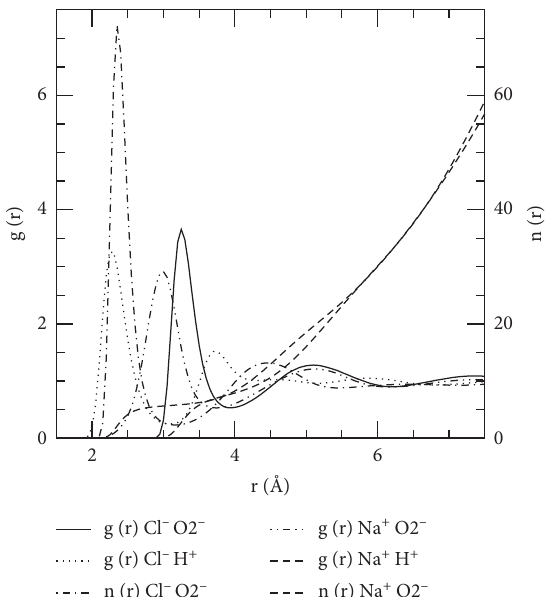
Figure 3: Radial distribution functions g g io ( r ) and ih ( r ) and the running hydration numbers n io ( r ) and n ih ( r ) of SPC/E water molecules for the A6 MD system at 25 ° C as a function of the distance r (˚A) between the ion (i) and the oxygen (O) and hydrogen atom (H) of a water molecule using Ewald sum with κ � 0.10 ˚A − Table 4: The average hydration numbers ( n io ( R 1 )) and residence times ( τ io , ps) of water molecules in the first hydration shells of Na in SPC/E water at 25 ° C employing a velocity Verlet algorithm where R 1 � 3.15 ˚A for Na + and R 1 � 3.95 ˚A for Cl − . System